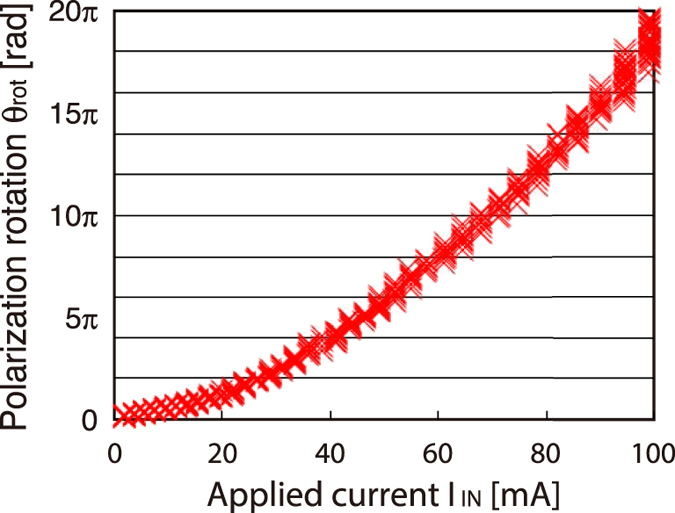
Relation between applied current IIN and polarization rotation θrot.